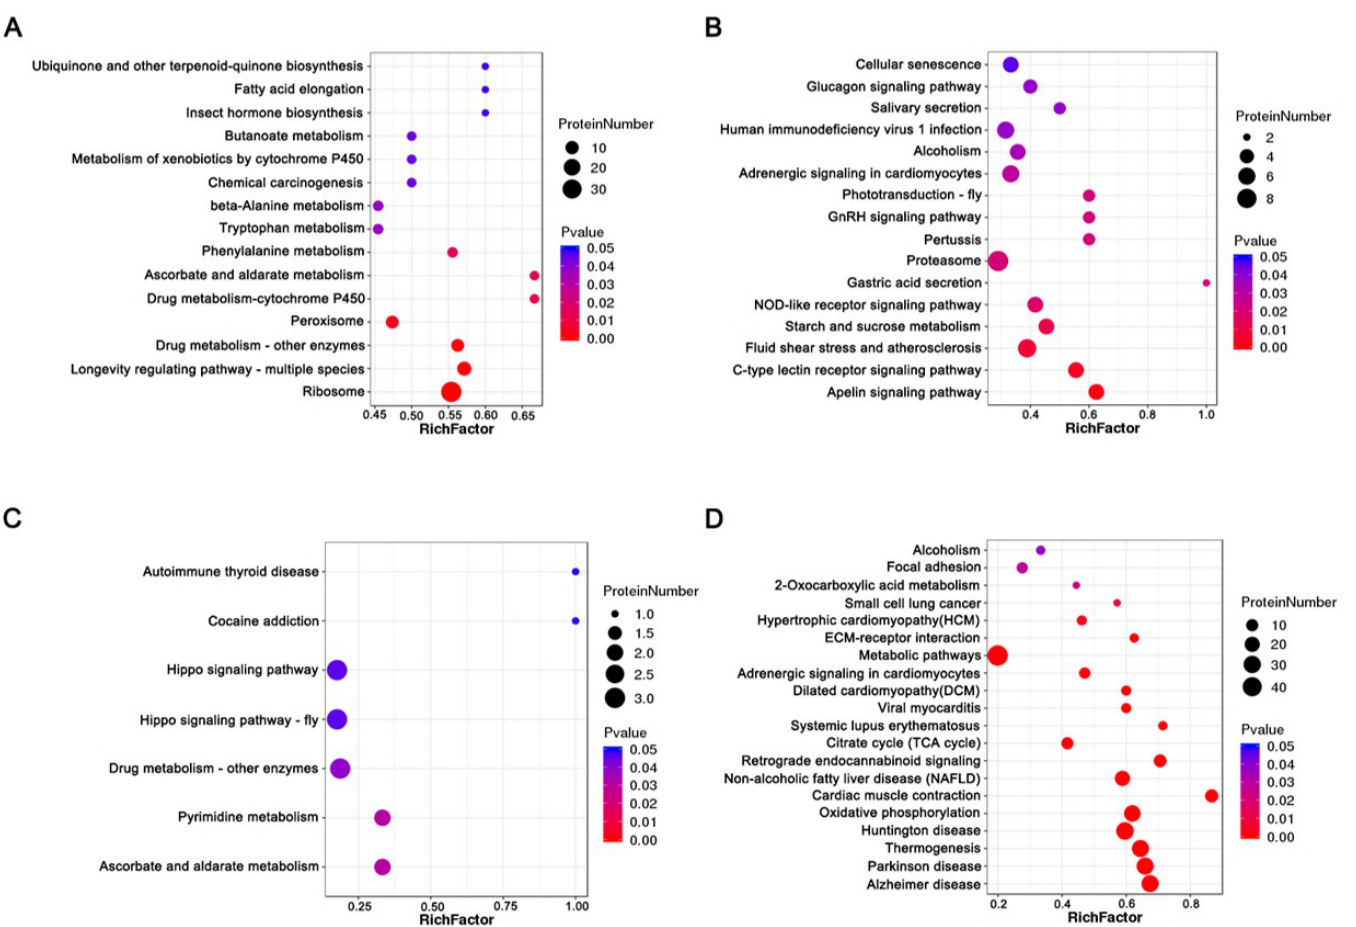
Figure 5. Bubble charts of KEGG pathway enrichment analysis of DAPs before and after thermal induction. ( A ) The enriched KEGG pathways for increased abundance proteins before thermal induction. ( B ) The enriched KEGG pathways for decreased abundance proteins before thermal induction. ( C ) The enriched KEGG pathways for increased abundance proteins after thermal induction. ( D ) The enriched KEGG pathways for decreased abundance proteins after thermal